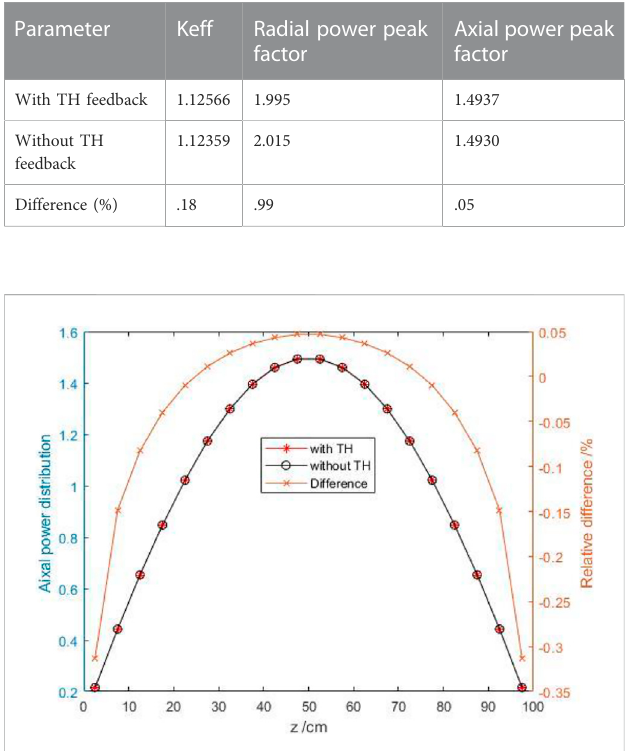
FIGURE 13 Compare axialpower distributionbetweenwithTH andwithoutTH